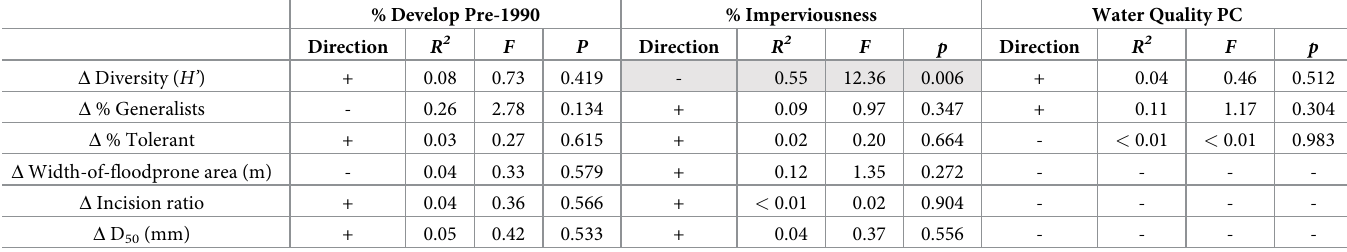
imperviousness. Direction indicates nature of relationship. Gray shading indicates significant